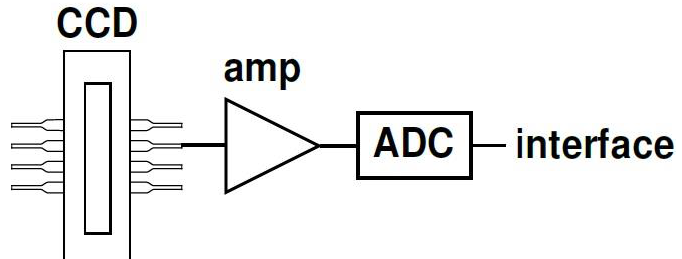
Figure 2. Simplified diagram of the basic internal circuit that connects the charge-coupled device (CCD) line with the interface (RS232 or USB) of the computer. The CCD line is connected via an amplifier (amp) with the analog-to-digital converter (ADC). The latter is either part of a microcontroller or connected to a microcontroller that communicates with the computer.